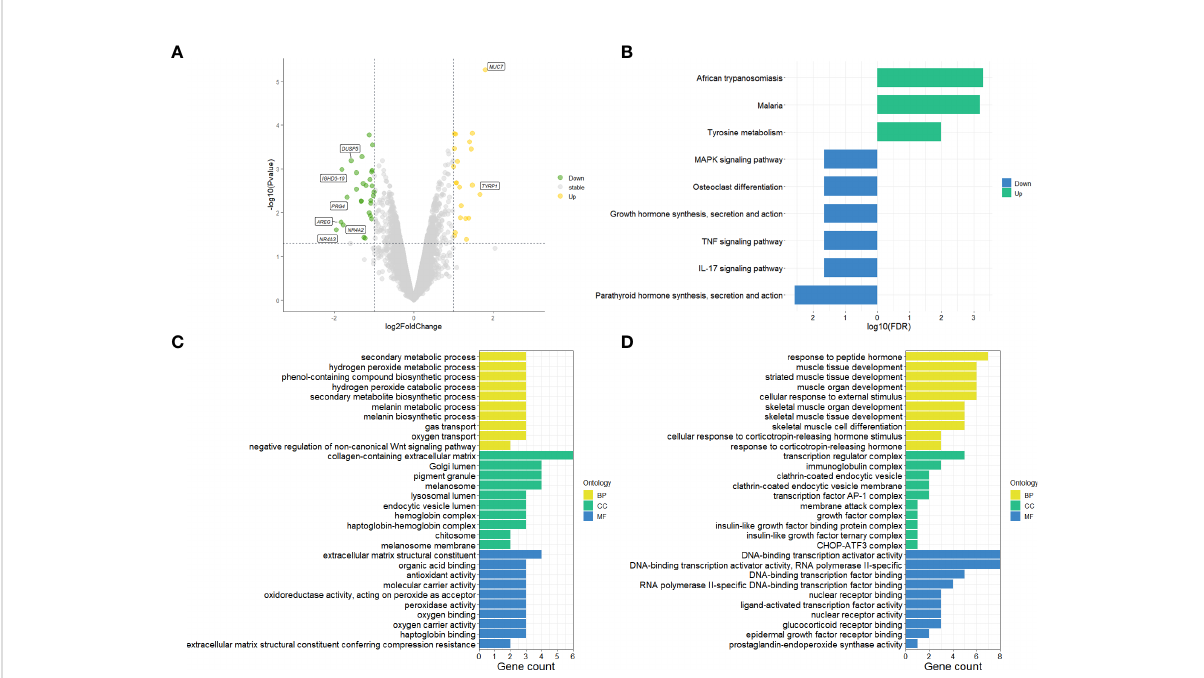
FIGURE 1 Results of microarray data analysis. (A) Volcano plot of microarray data, upregulated genes fi ll with yellow while downregulated genes fi ll with green. Grey dots mean genes are stable. The dotted horizontal lines indicate a p.value of 0.05, and the vertical lines indicate a log2FC of 1. Genes (|log2FC| > 1.5) labeled with their gene symbol are shown in the Figure. (B) KEGG analysis of DEGs of pterygium. The green color indicates upregulation, and blue indicates downregulation. (C) Top 30 upregulated GO terms for DEGs in different classi fi cations. (D) Top 30 downregulated GO terms for DEGs in different classi fi cations. The selection criteria of signi fi cant pathways or GO terms was FDR < 0.05. log2FC, log2foldchange; GO, Gene Ontology; KEGG, Kyoto Encyclopedia of Genes and Genomes (http://www.genome.jp/kegg/); FDR, false discovery rate. BP, biological process; CC, cellular component; MF, molecular